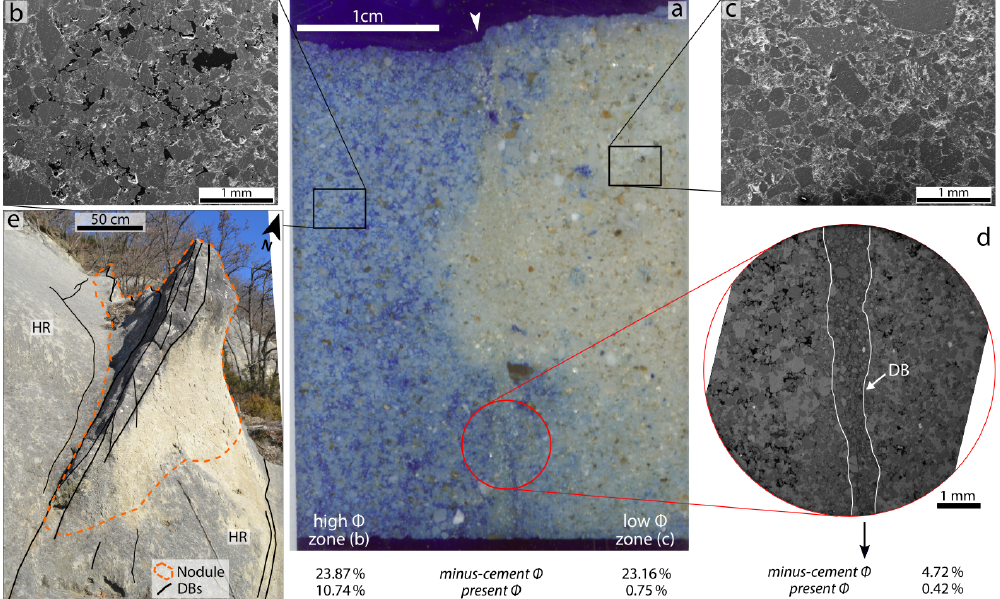
Figure 9. Host rock (HR) and DB porosity as well as relationships between cement and DBs in the Loiano Sandstones. (a) Polished thin sections impregnated with blue-dyed resin. The section shows a DB (arrow) separating two host rock sectors: on the right-hand side there is extensive calcite cementation, whereas on the left-hand side cementation is poor. (b, c) Secondary electron and (d) backscattered electron SEM images from different sectors of the section (a) . Porosity ( φ ) estimation data in (a–d) are from Del Sole and Antonellini (2019). (e) Field example for which a nodule is asymmetrically placed on a side of the DBs, similarly to what is observed in (a) . See text for further details.